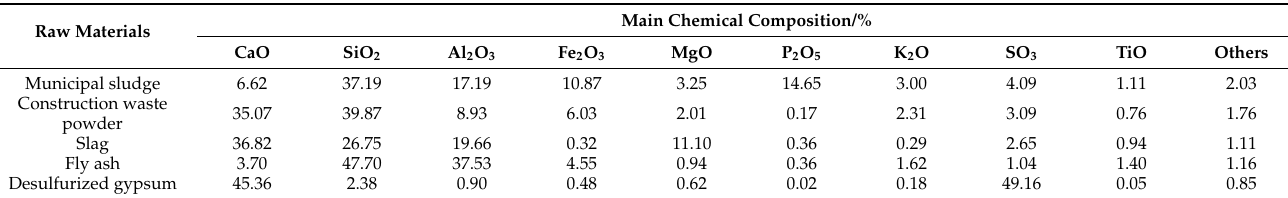
Table 1. Chemical composition and content of test